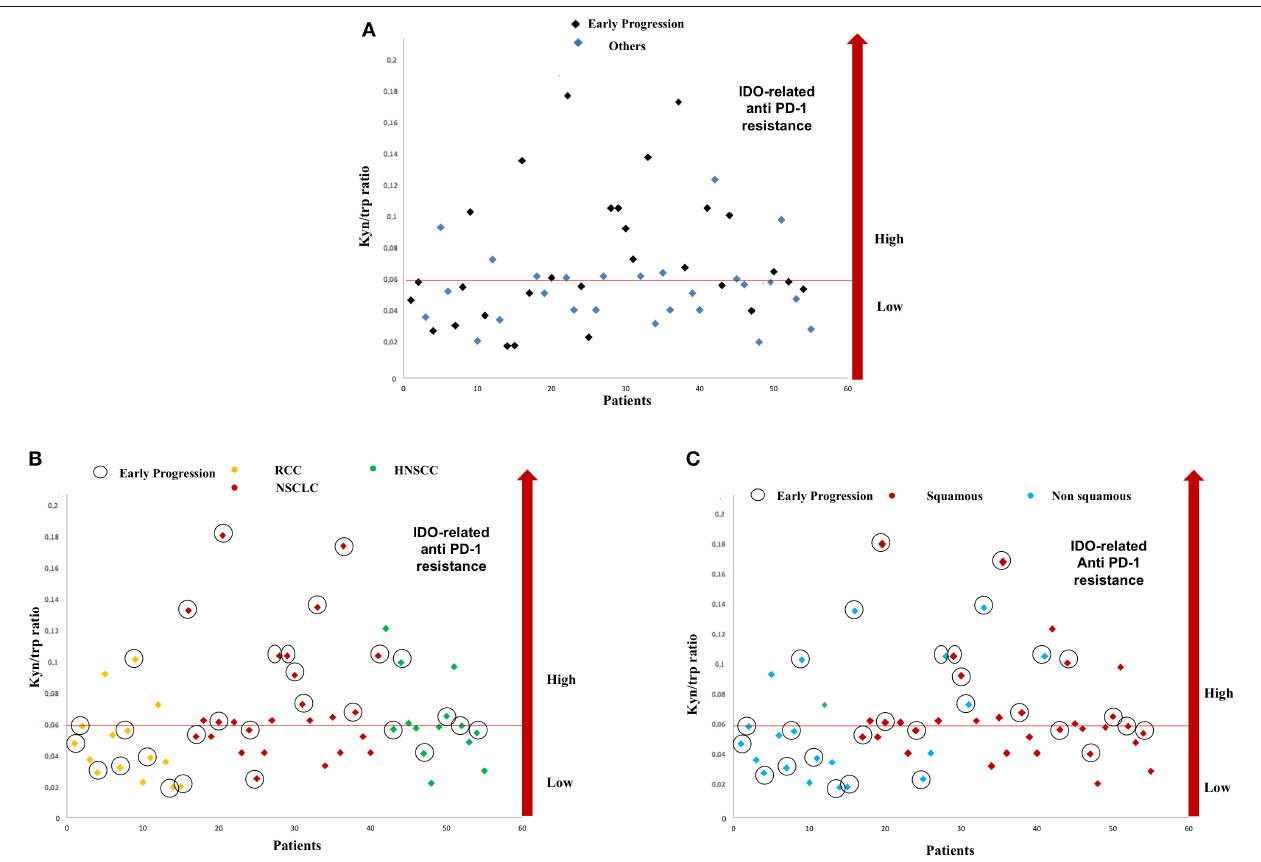
FIGURE 1 | Distribution of serum kyn/trp ratio and early progressions in study population (A) . Distribution of serum kyn/trp ratio and early progression according to primary tumor site (B) and on the basis of the squamous histology (C) . kyn, kynurenine; trp, tryptophan.